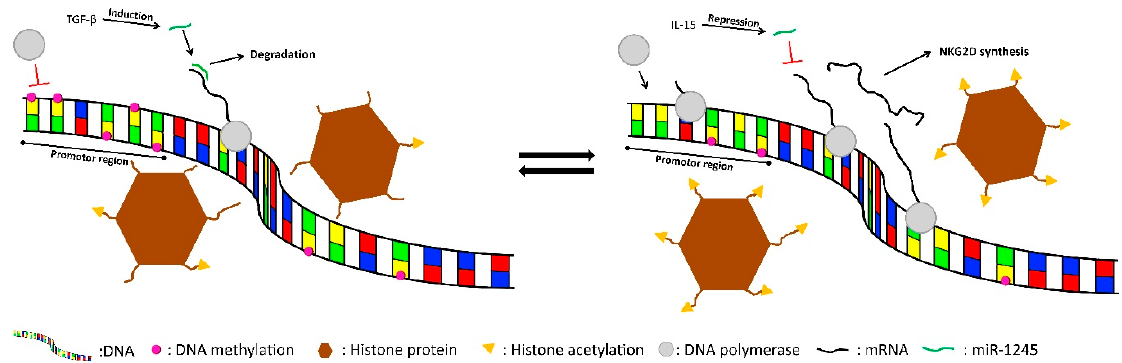
Figure 1. Epigenetic regulation of NKG2D. DNA methylation in the promoter region and deacetylated histone 3 lysine 9 (H3K9) suppress gene expression. TGF- β induces miR-1245 leading to a degradation of NKG2D mRNA. If DNA is demethylated and histones are acetylated, gene expression is more pronounced. IL-15, an inducer of NKG2D expression, represses miR-1245 synthesis.